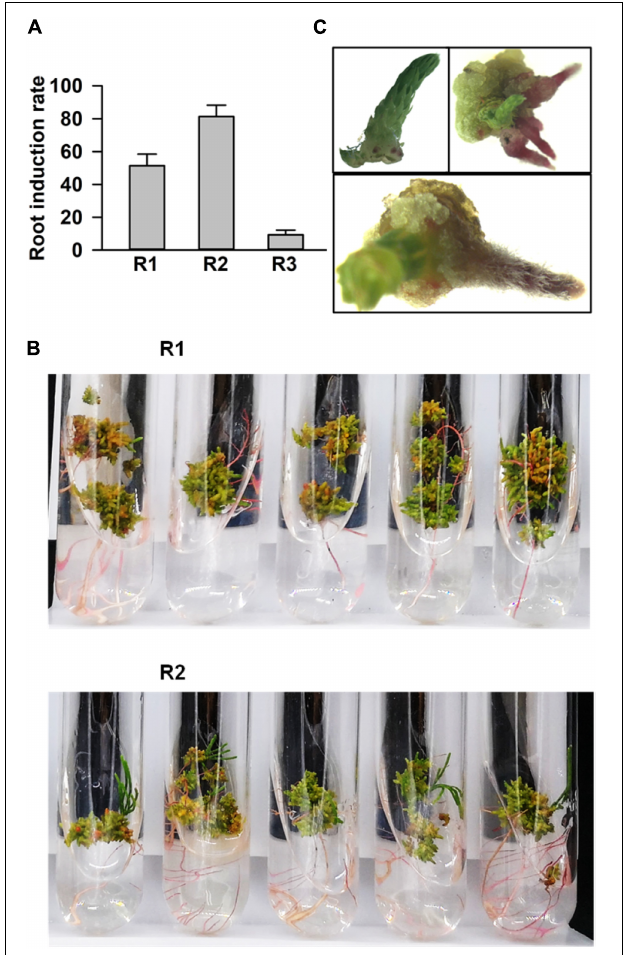
FIGURE 3 | Root regeneration of adventitious buds. (A) Root induction rate in basal medium with different plant growth regulator (PGR) combinations. The results are presented as the mean and standard error from three independent experiments. (B) Comparing roots in the R1 and R2 media. (C) Different stages of induced